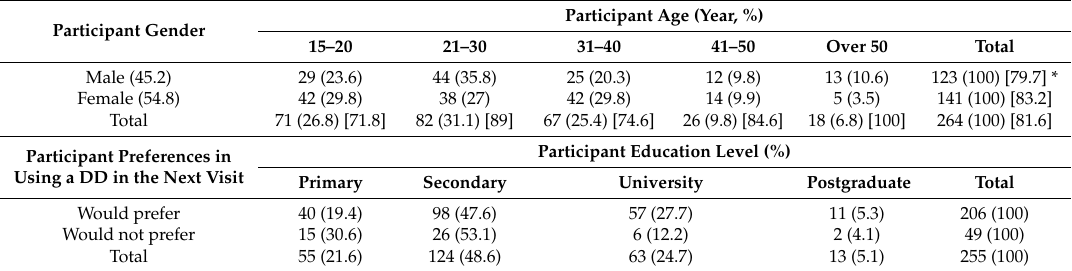
Table 2. The correlation of participant gender, age (years) and level of education with their preference on using a DD in the next visit ((%) and [%]).